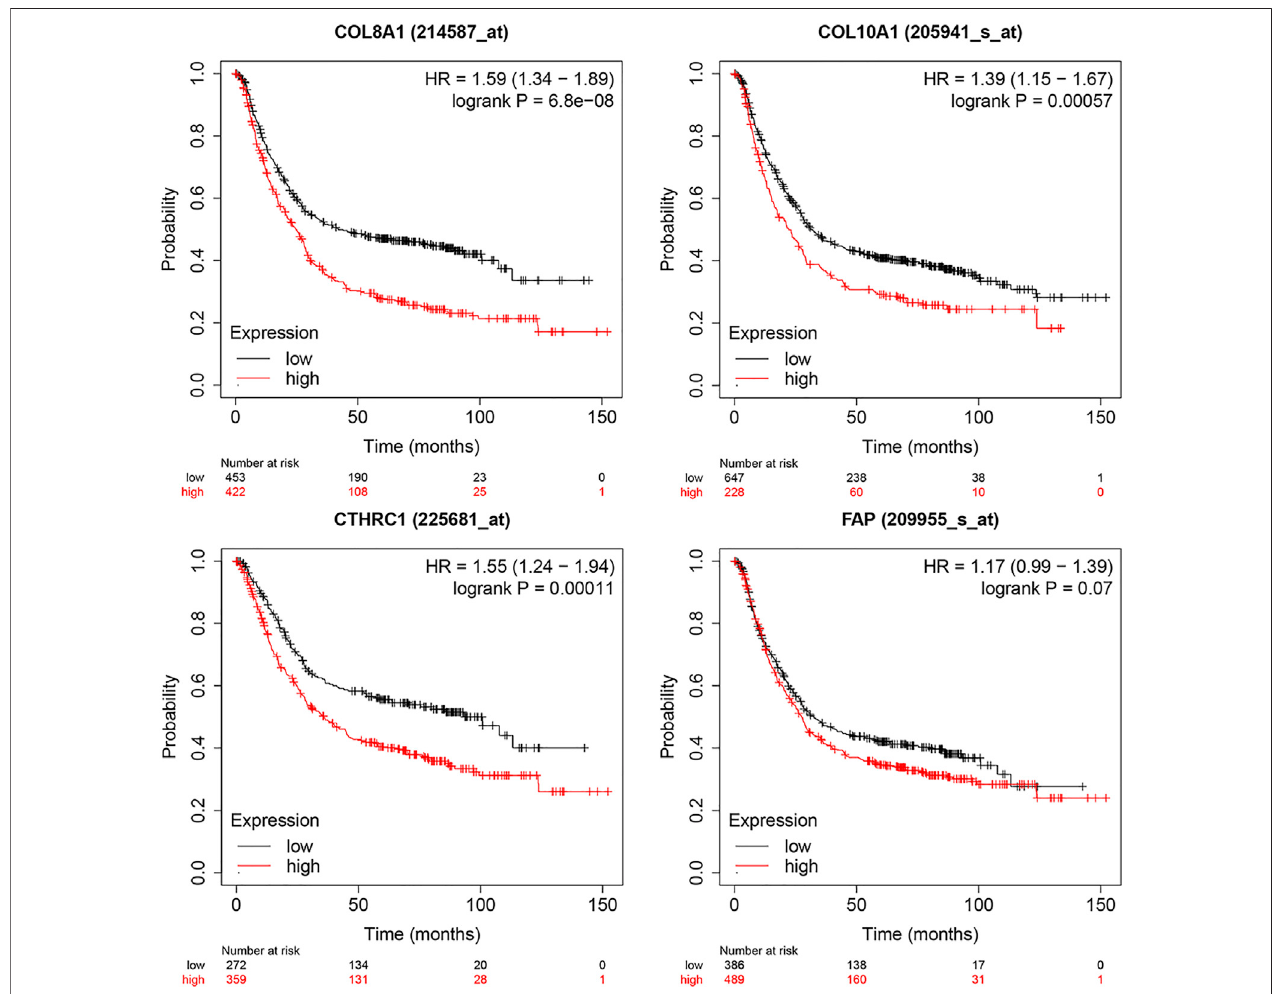
FIGURE 4 | Survival analysis of Collagen Type VIII Alpha 1 Chain (COL8A1), Collagen Type X Alpha 1 Chain (COL10A1), Collagen Triple Helix Repeat Containing 1 (CTHRC1), and Fibroblast Activation Protein (FAP) by Kaplan – Meier